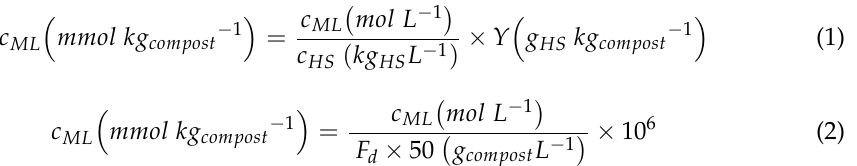
)), CVDW (red ( )), (cid:35) (cid:51)